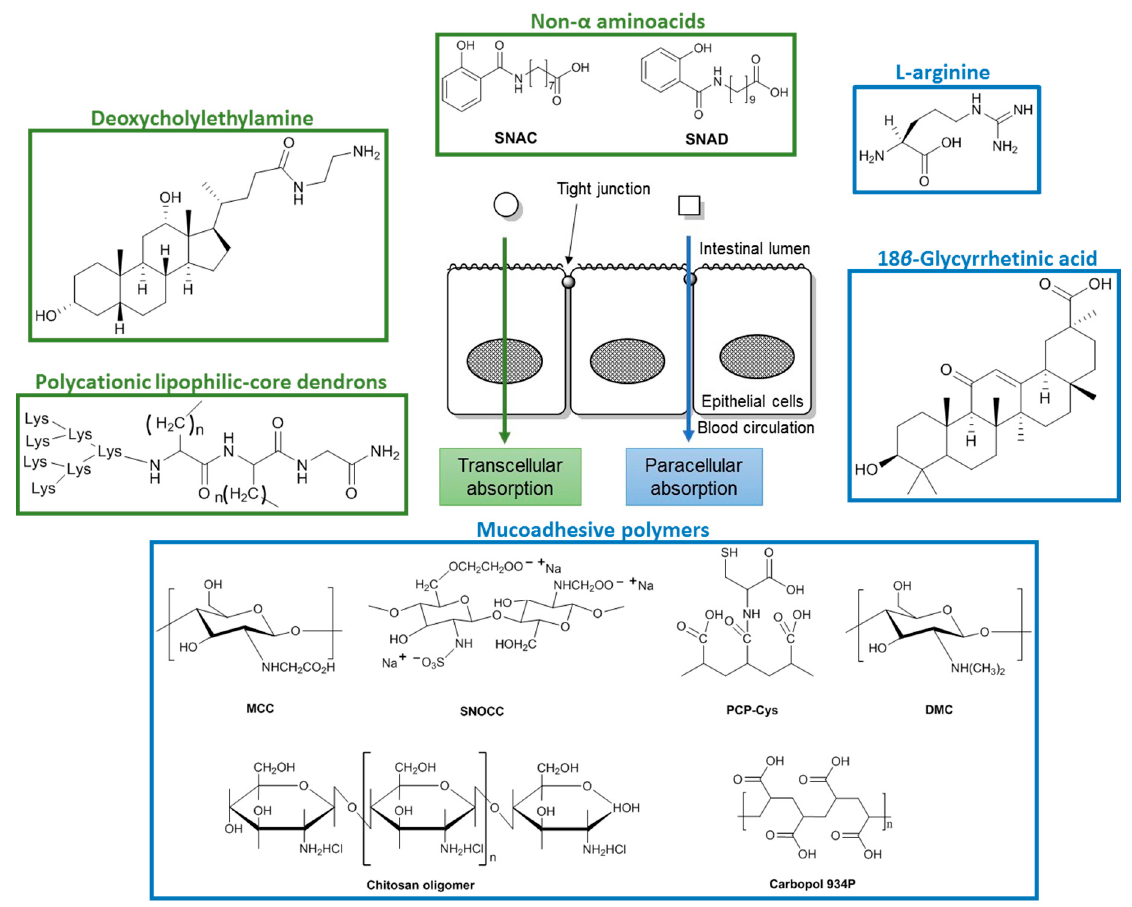
Figure 5. Chemical structure of penetration enhancers that increase oral bioavailability of